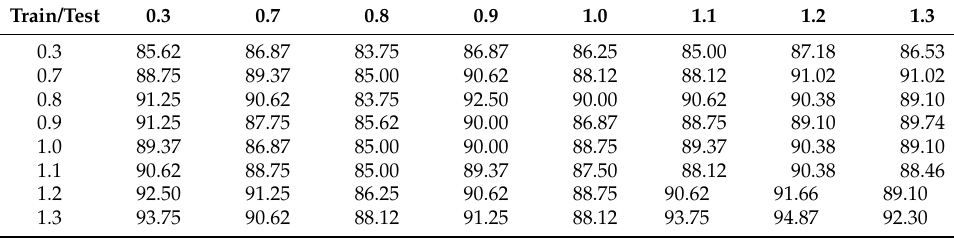
Table 7. Accuracy obtained by LM 136 with different resizing factors (reported in percentage). Train/Test